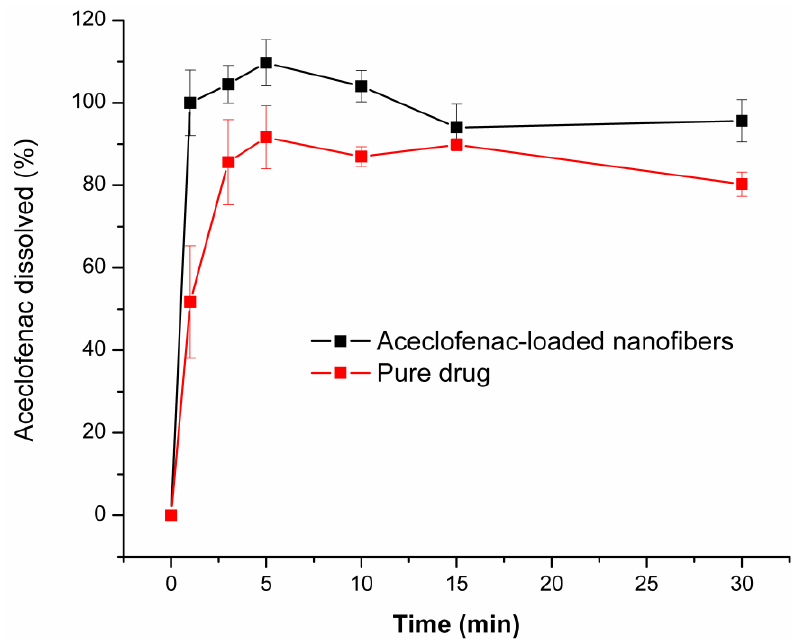
Figure 6. Dissolution profile of aceclofenac-loaded nanofibers (composition N2 of polymeric solution: 10 mg / g aceclofenac, 15 w / w % PVP, 1 w / w % trolamine in ethanol:water 75:25 w / w %) and pure active substance (average of three measurements ± SD).